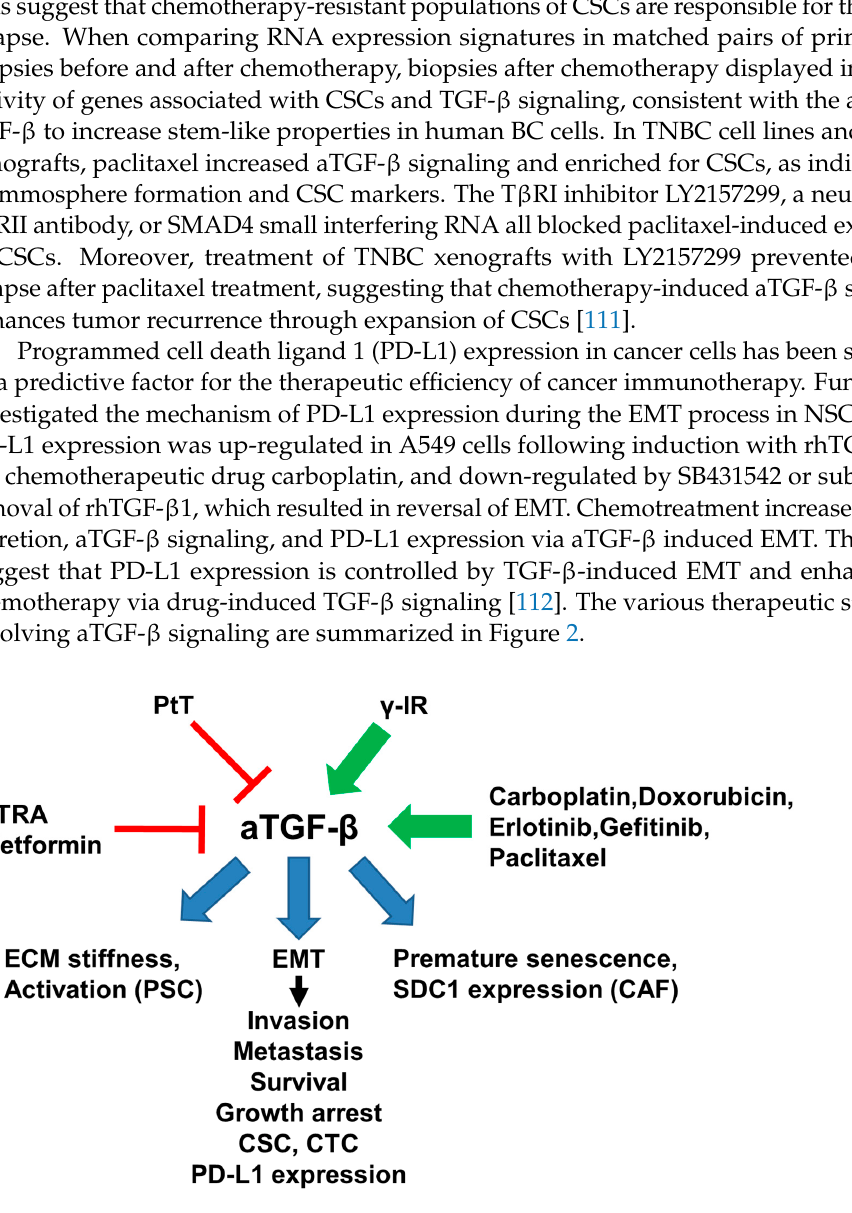
Figure 2. Cartoon illustrating various therapeutic interventions that converge on aTGF- β signaling. ATRA, all trans-retinoic acid; CSC, cancer stem cell; CTC, circulating tumor cell; PtT, photothermal therapy. Red lines denote inhibition, green arrows indicate induction/activation, and blue arrows point to the cellular processes targeted by aTGF ‐β . For details see text. 4. General Considerations and Caveats in Studying Autocrine TGF ‐β Signaling While paracrine signaling—the communication via soluble factors between two dif ‐ ferent types of cells—is more common in normal physiology, autocrine signaling loops with positive or negative feedback are an important feature in cancer, where they drive cancer ‐ associated processes such as proliferation, survival and migration/invasion, and enable context ‐ dependent cell signaling. Here, the composition of the TME can critically affect the intracellular signaling dynamics triggered by extracellular stimuli. More specif ‐ ically, the signaling response to a transient input is short ‐ lived when most of the released ligand is lost to the cellular microenvironment, i.e., by diffusion or interaction with an extracellular ligand ‐ binding factor, but prolonged or persistent in a cell that efficiently recaptures the endogenous ligand. Shvartsman and colleagues developed a mathematical model that accounts for all parts of an autocrine loop by showing that context ‐ dependent signaling arises as a result of dynamic interactions between ligand release, transport, bind ‐ ing, and intracellular signaling [113]. Autocrine and paracrine signaling mechanisms are traditionally difficult to investi ‐ gate due to the sub ‐ micromolar concentrations involved and the limited technology to detect these. A microfluidic cell culture perfusion system has been developed that could control the removal of molecular factors secreted by cells into the culture supernatants [114] and Blagovic and colleagues have employed this system to continuously remove the secreted factors to downregulate diffusible signaling. Moreover, by comparing cell growth and differentiation in side ‐ by ‐ side chambers with or without added cell ‐ secreted factors, they were able to discern the effects of diffusible signaling from artifacts such as shear, nutrient depletion or micro ‐ system effects [115]. Using this device, a comparison between minimal chemically ‐ defined medium and medium fully supplemented with cell ‐ secreted factors and in the absence or presence of added TGF ‐β signaling inhibitors, could be set up to determine the relative contribution of TGF ‐β and non ‐ TGF ‐β secreted factors in promoting a specific cellular response in a specific cell type. The studies discussed above impressively prove the crucial role of endogenous TGF ‐ β and its eventual autocrine/paracrine modes of action in all cardinal processes driving tumor initiation and progression. The various TGF ‐β isoforms either operate on their own